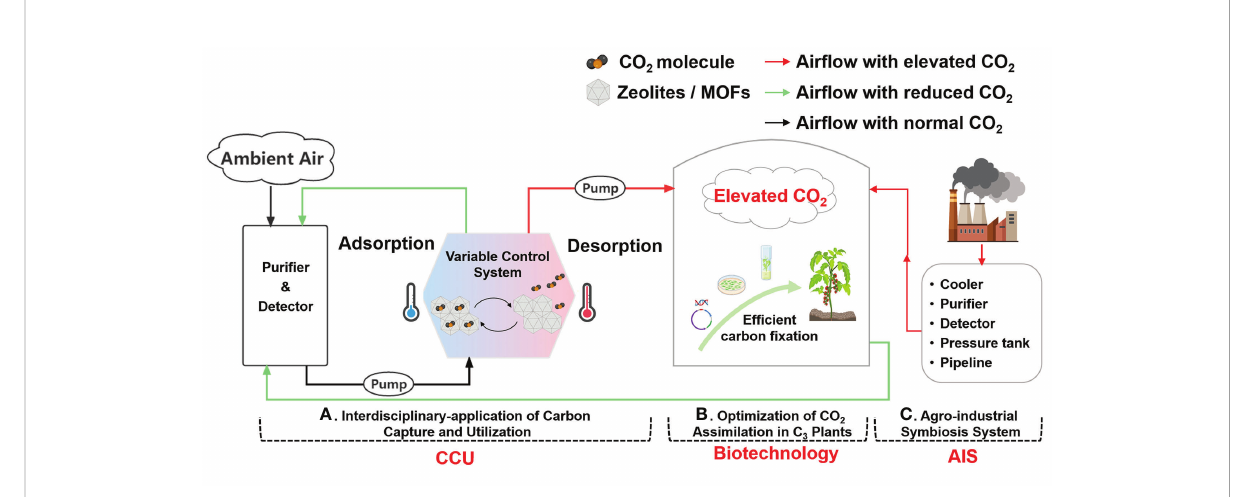
FIGURE 3 Overview of directions for future CO 2 enrichment in greenhouse production. (A) Interdisciplinary application of carbon capture and utilization. Zeolites/MOFs as carbon adsorption materials can adsorb CO 2 molecules from ambient air at low temperatures and desorb them at high temperatures to enrich CO 2 into greenhouses. (B) Optimization of CO 2 assimilation in C 3 crops. Limited CO 2 assimilation ability in C 3 crops can be improved via biotechnological approaches including gene manipulation and genetic transformation. (C) Agro-Industrial Symbiosis system. A direct connection between the energy industry and greenhouses can be built through a pipeline network to convey CO 2 and heat. Created with